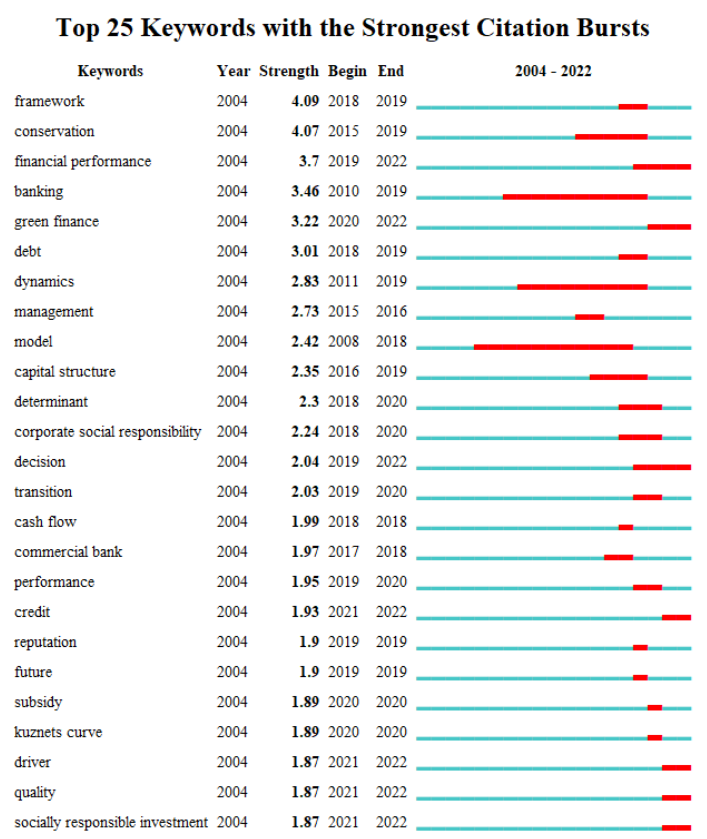
Figure 17. WOS outburst diagram.